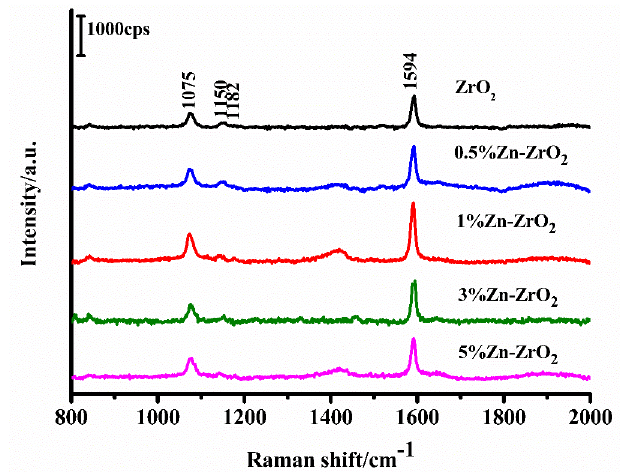
Figure 8. The SERS spectra of 4–MBA adsorbed on the ZrO 2 and Zn–ZrO 2 NPs.